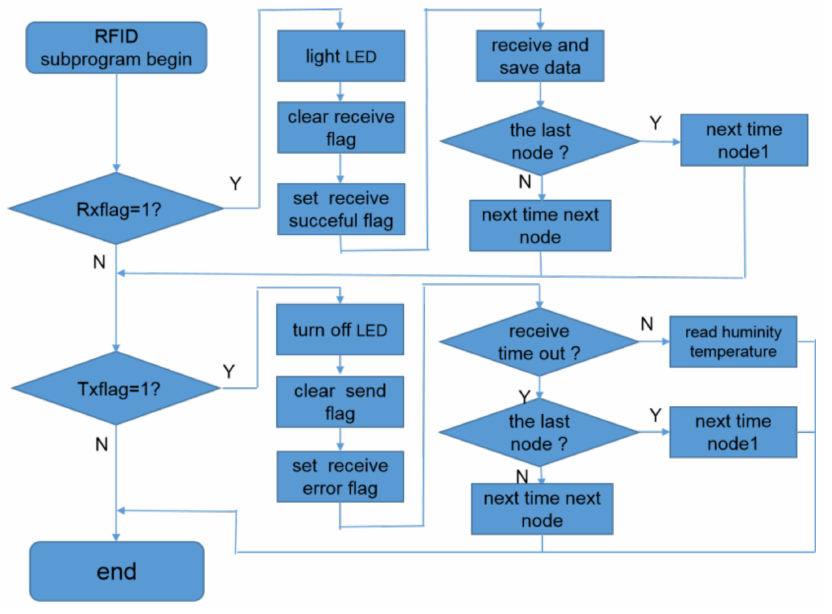
Figure 6. The flowchart of RFID subprogram of sink